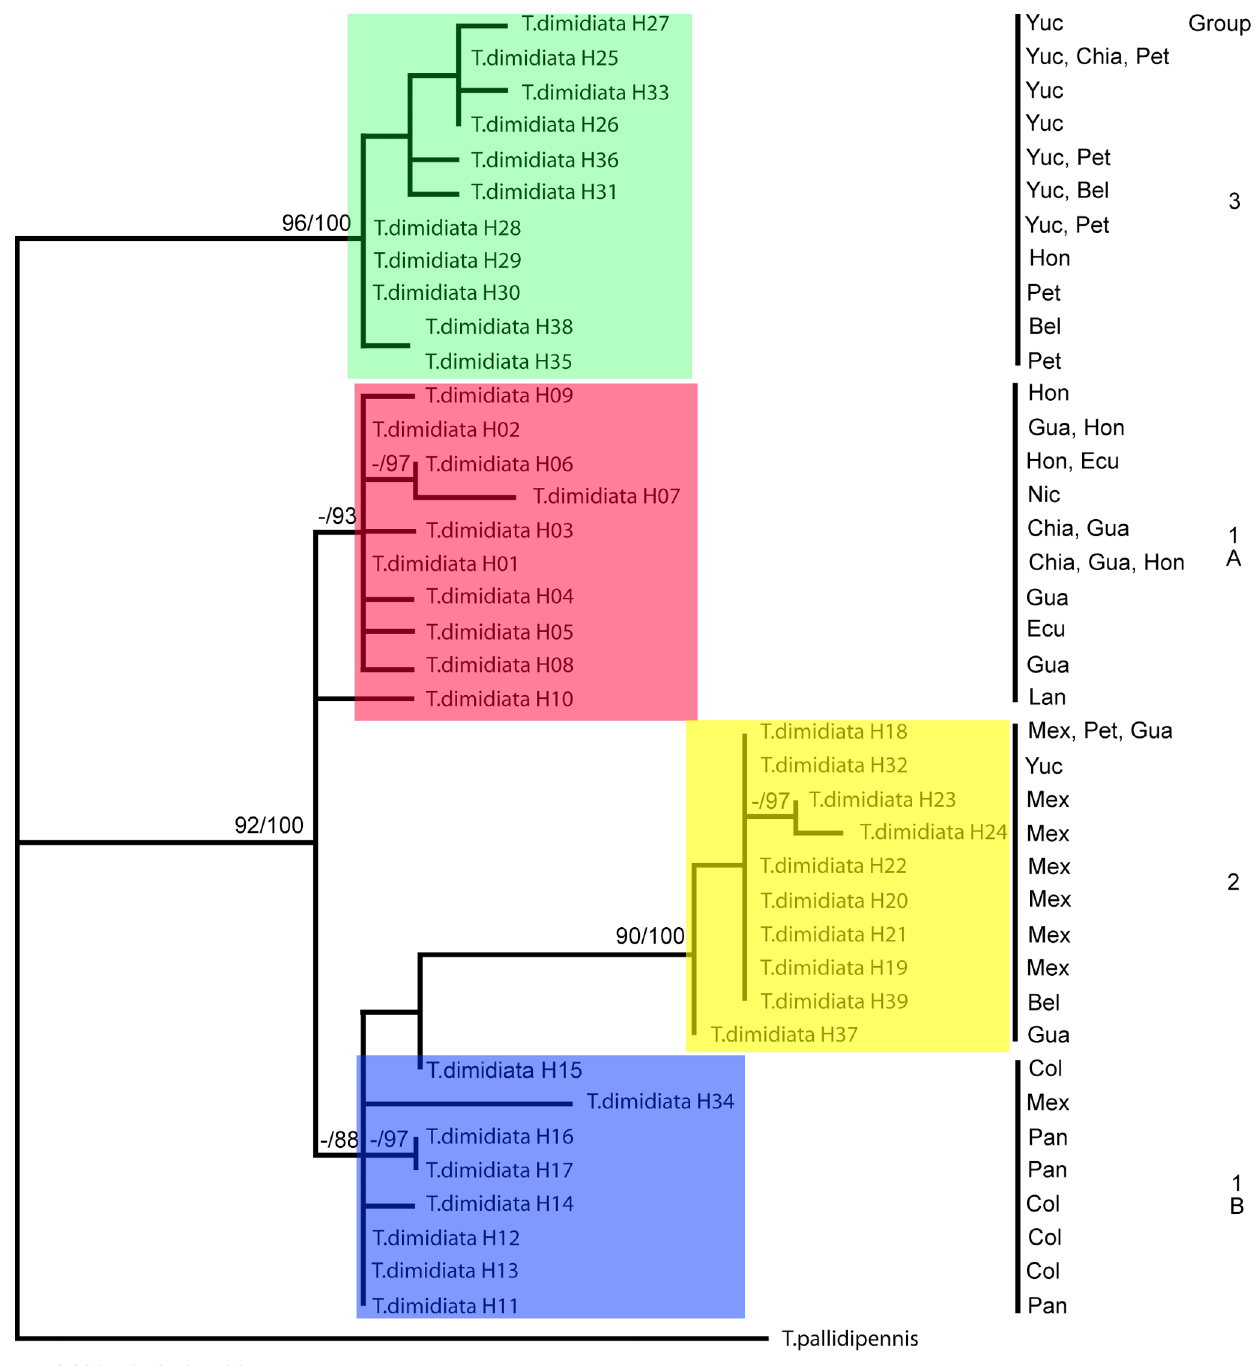
Figure 3. Phylogenetic maximum likelihood tree of all 39 haplotypes of T.dimidiata ITS2 sequence. Number of substitutions per site is indicated by the bar and bootstrap values higher than 75% / Bayesian posterior probabilities larger than 85% are indicated at the nodes. Yuc=Yucatan, Mexico (MX); Chiapas=Chiapas, MX; Peten=Peten, Guatemala (GT); Bel=Belize; Hon=Honduras; Ecu=Ecuador; Nic=Nicaragua; Lanquin=Lanquin, Alta Verapaz, Guatemala; Mex=Mexico; Pan=Panama; Col=Colombia. T. pallidipennis is the outgroup. ITS2 Groups coded as follows: 1A (red), 1B (blue), 2 (yellow), 3 (green). doi:10.1371/journal.pntd.0000393.g003 [38]. Our ITS2 data from an additional eight haplotypes supports Mexican (and Guatemalan) and Central American T. dimidiata (ITS2 estimated time of divergence of 1.02–2.47 my) is also supported by this classification and we show that the ‘‘southern Mexico’’ Group 2 extends well into southern Guatemala where it overlaps with the antenna structure, head morphometry, and cuticular hydrocarbon Central American Group 1A. This division between a southern analysis. (Cytogenetics and morphometry of male genitalia do not